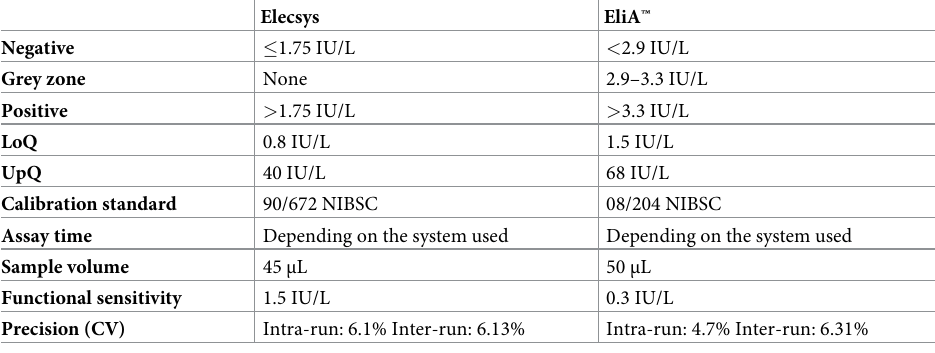
Table 2. Manufacturer specifications of the compared